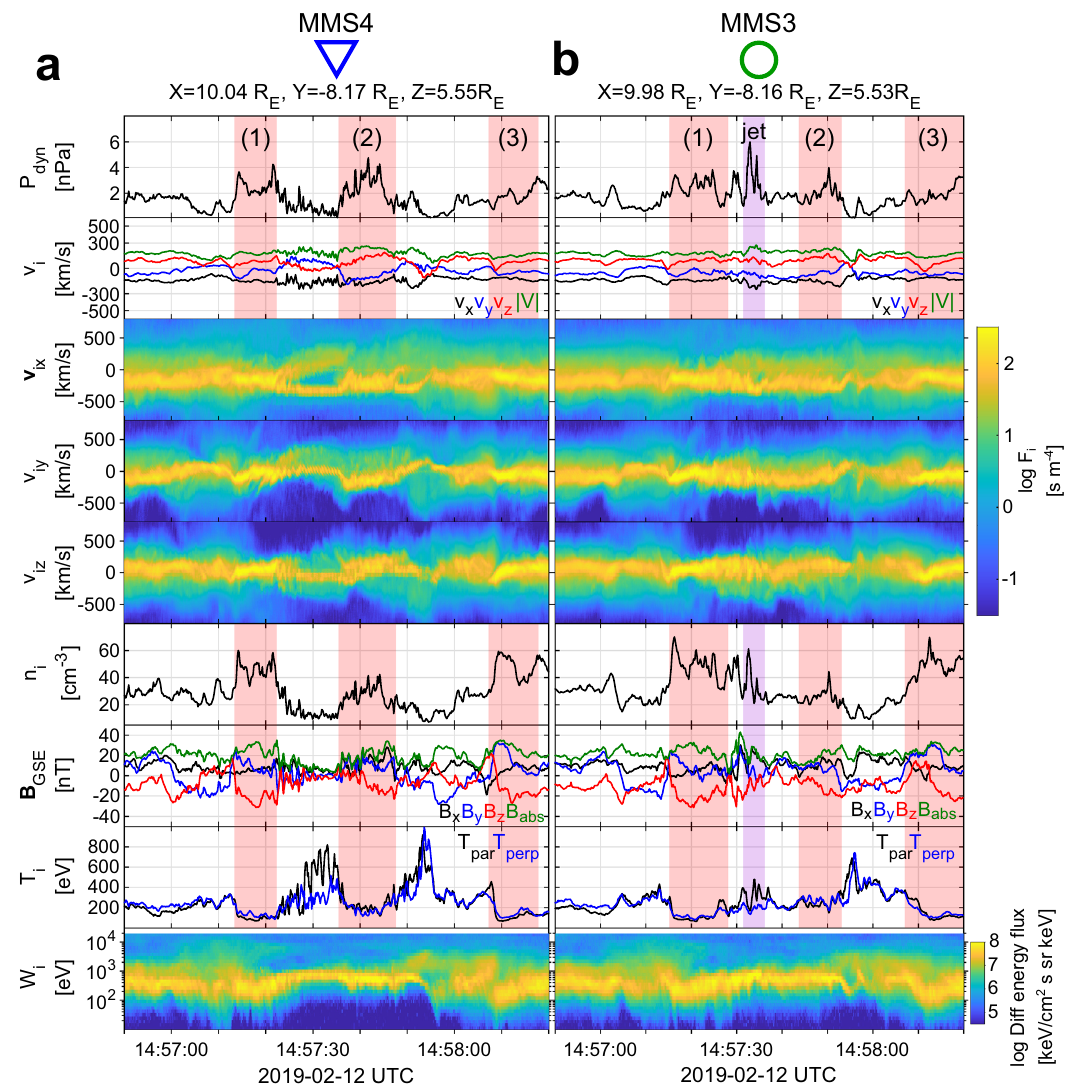
Fig. 3 Spacecraft position and overview of the measurements for Magnetosphere Multiscale (MMS) 4 and 3. a , b Overview observations in Geocentric Solar Ecliptic (GSE) coordinates of the two innermost MMS spacecraft ordered by distance to the Earth (MMS4 - blue triangle, and MMS3 - green circle). From top to bottom, ion dynamic pressure, ion bulk velocity fl ow, v x , v y , v z 1D reduced ion velocity distribution functions (VDFs), ion number density, magnetic fi eld, ion temperature, and ion differential energy fl ux spectrum. Areas of interest have been marked with colors, red for sequentially observed shock fronts (which are also numbered), and purple for the observed